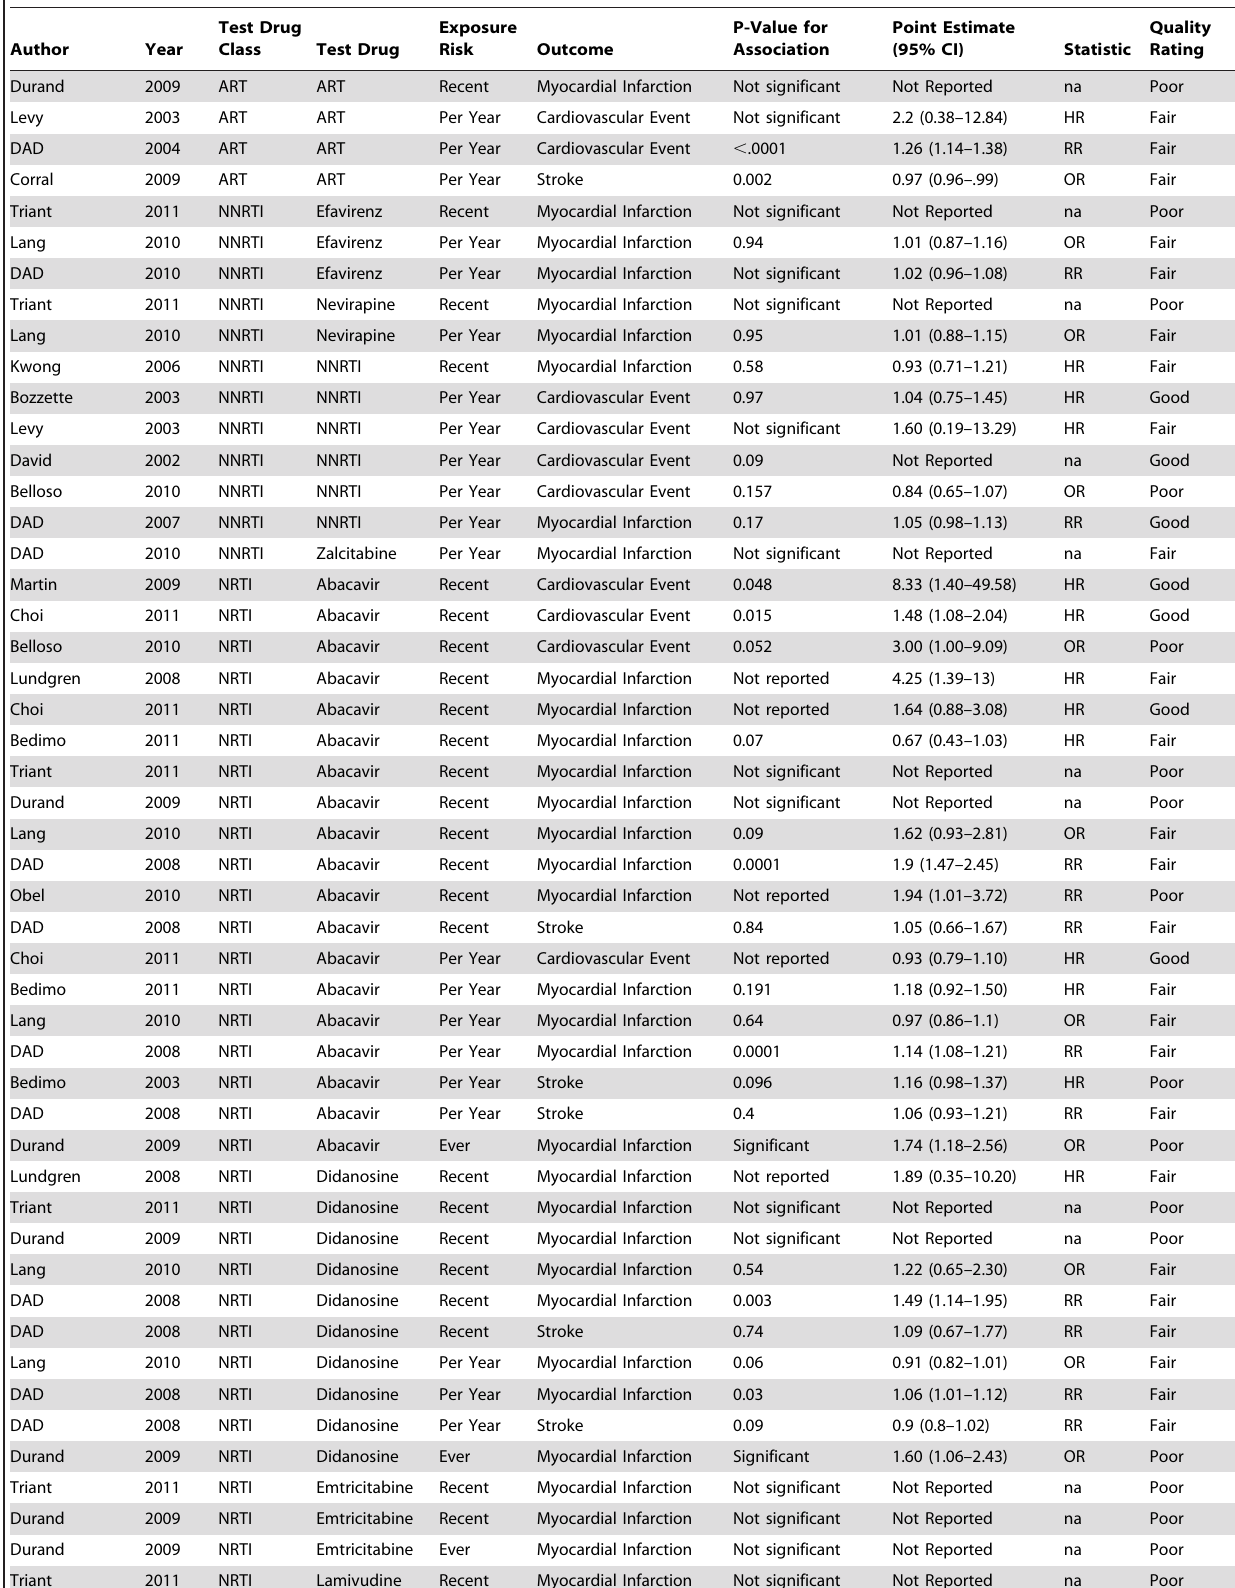
Table 1. Description of All Included Studies, ART, NNRTI, and